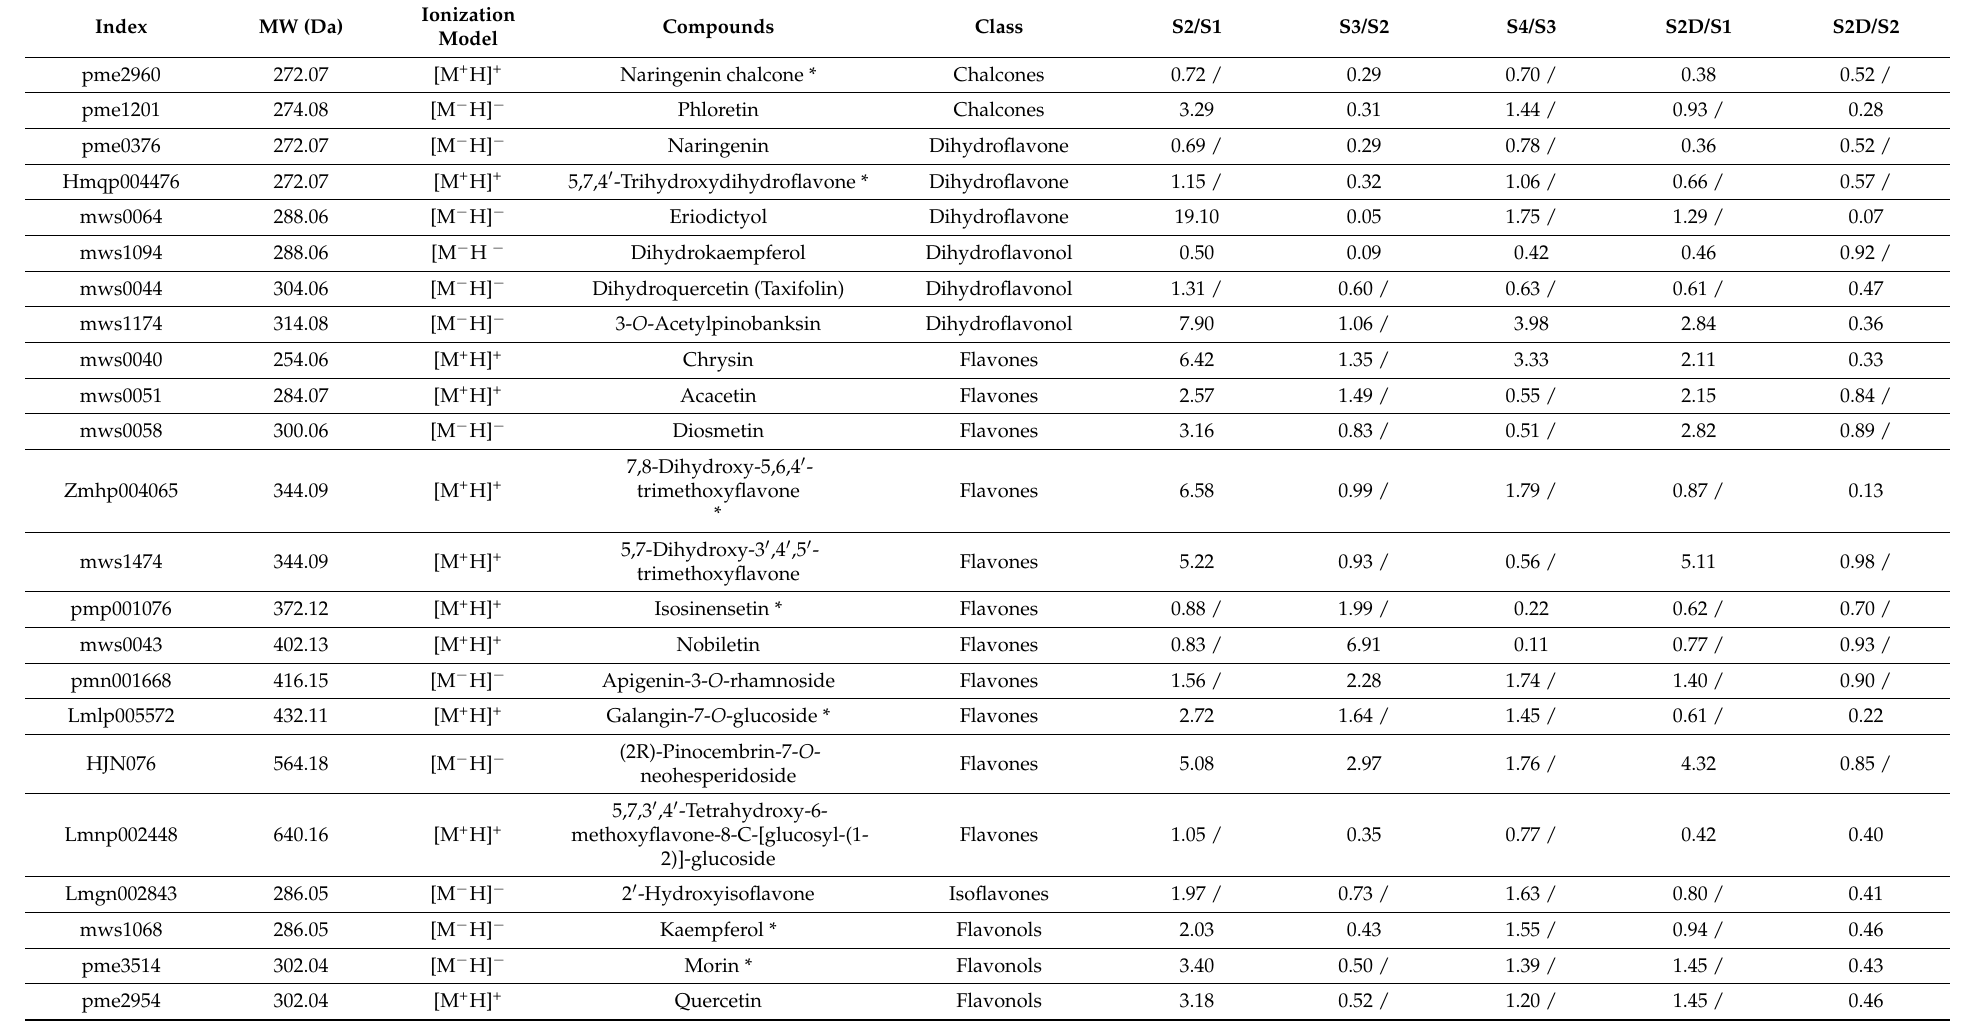
Table 1. The information of differential metabolites from five comparison